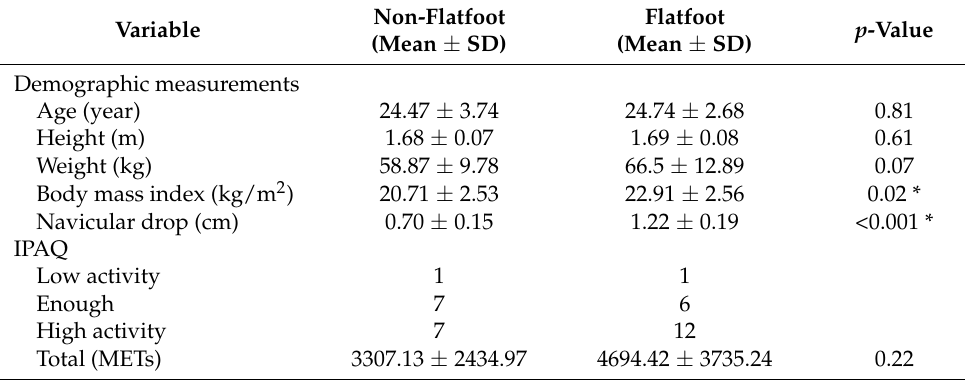
Table 1. Baseline demographic data.